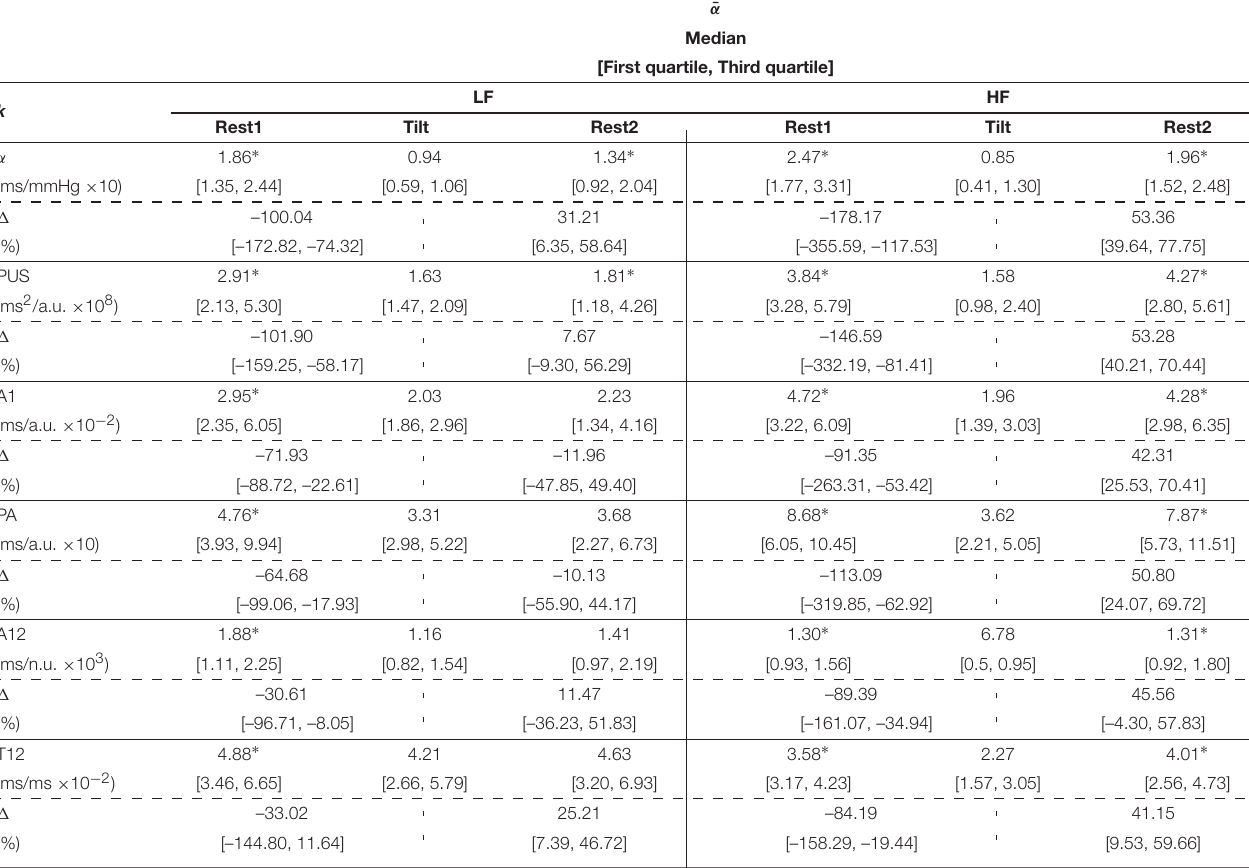
TABLE 3 | Inter-subject median and interquartile ranges of intra-subject median of ¯ α { LF,HF } and ¯ α { LF,HF } k